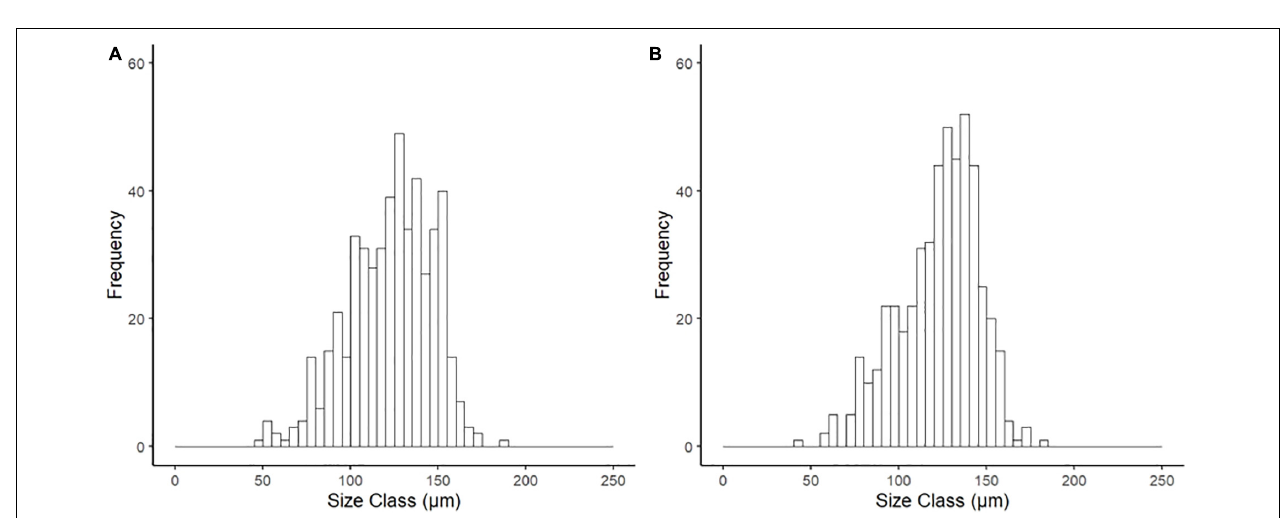
FIGURE 2 | Size frequency of oocytes for Astarte crenata from the Barents Sea following incubation (20 weeks) under (A) ambient and (B) representative future climate conditions. There was no difference in distribution between treatments (2-tailed K–S test, D ( 116 ) = 0.062, p =